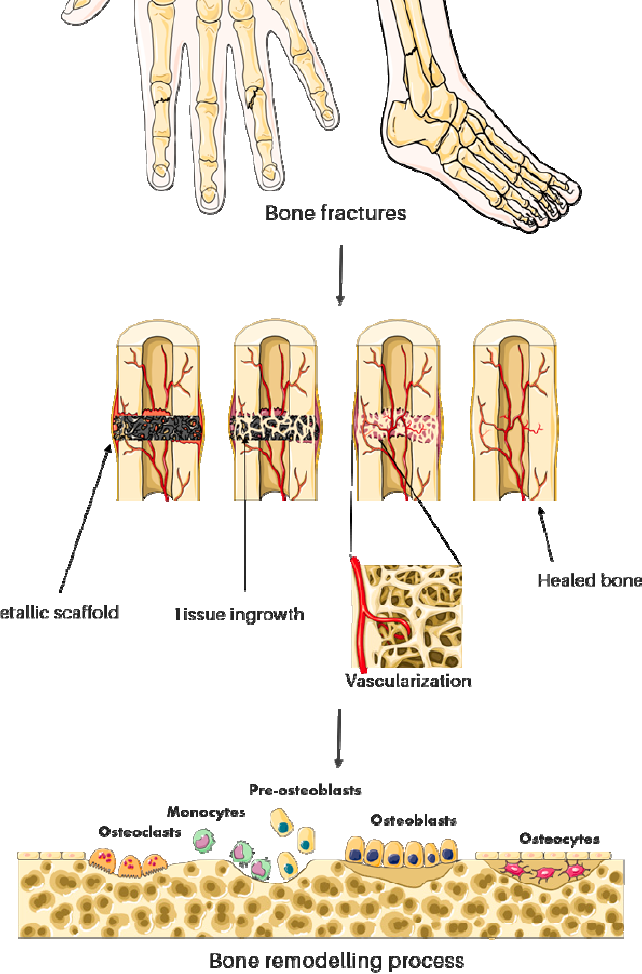
Figure 1. Schematic representation of the process of bone regeneration with subsequent resorption of the metallic scaffold. Reproduced under the terms and conditions of the Creative Commons Attribution 3.0 Unported License [43] Copyright: Servier Medical Art by Servier. A modification of the illustration by the addition of a representation of the metallic scaffold was made by authors.